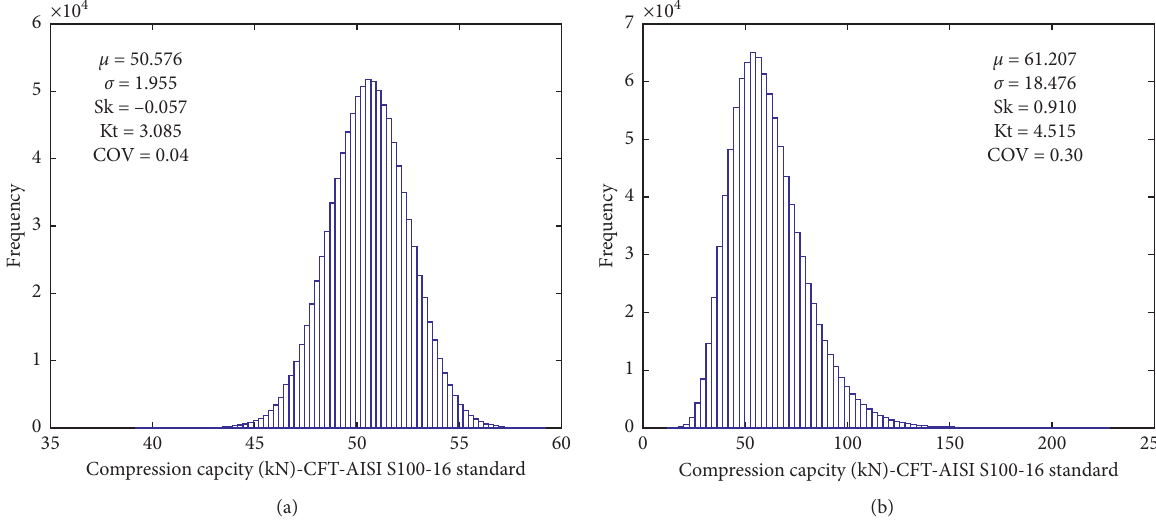
Figure 10: Compression capacity histograms for AISI S100-16 & AS/NZS 4600: 2018 Standard: (a) compression capacity without ME; (b) compression capacity with ME. CFT—Column flexure-torsion buckling mode, μ —Mean, σ —Std. deviation, Sk—Skewness, Kt—Kurtosis, and COV—Coefficient of variation.